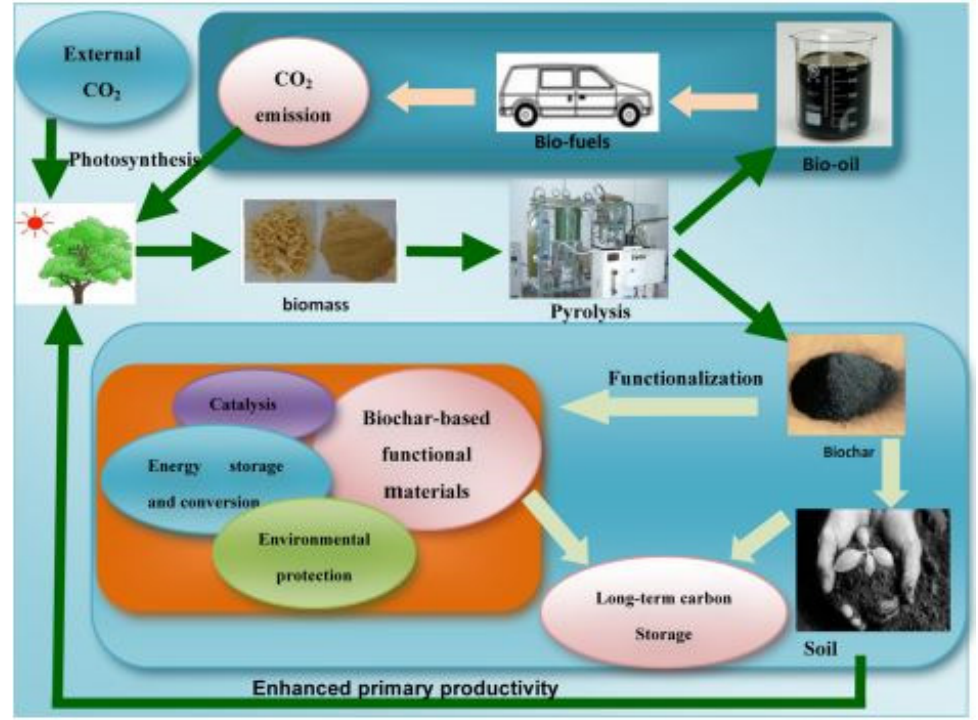
Figure 1. Representation of sustainable principles in biochar synthesis, uses, and overall climate effects. Reprinted with permission from Ref. [40]. Copyright 2015, copyright American Chemical Society.